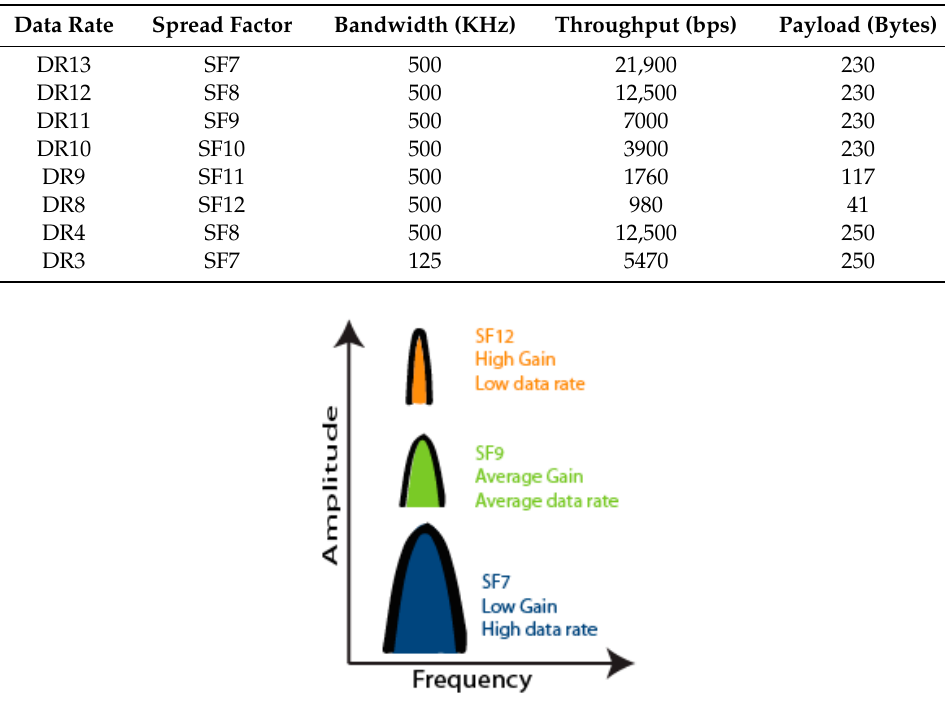
Table 6. LoRa parameters in US902-928 and AU915-928 bands, frequency of 915 MHz [56].